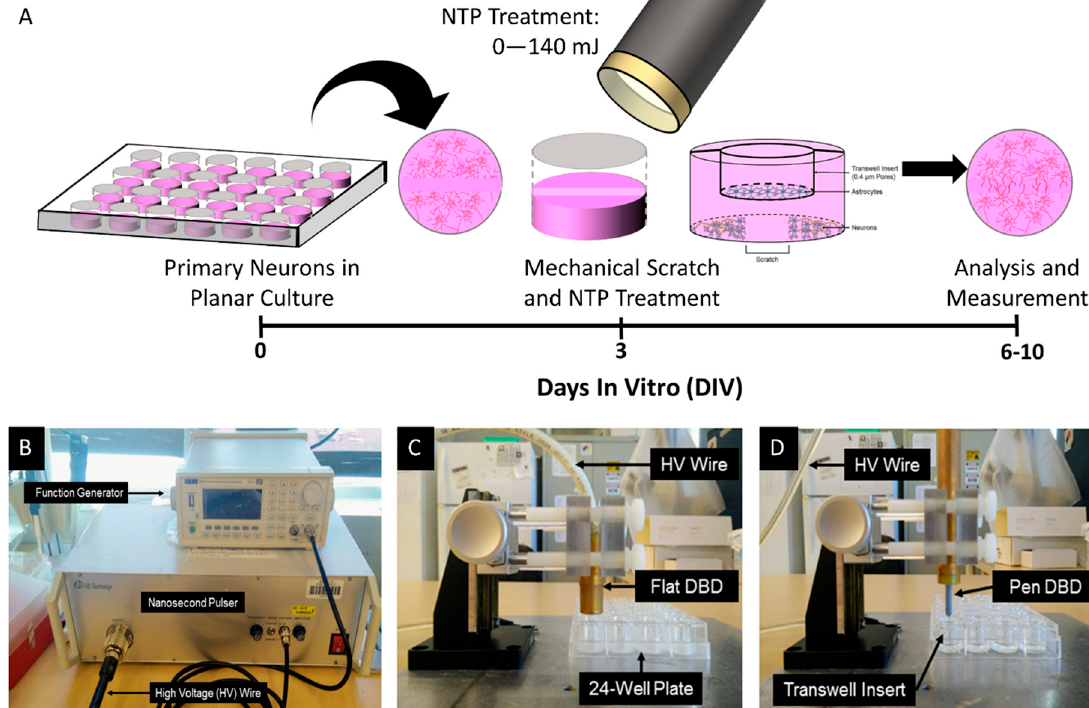
Figure 1. Non-thermal plasma (NTP) was applied to neural cultures using a nanosecond-pulsed dielectric barrier discharge (nspDBD) system for all plasma treatments. ( A ) Primary neurons were plated in 24-well plates, subjected to mechanical disruption via a scratch assay, and treated with NTP 3 days after plating. For the co-culture group, astrocytes cultured in Transwell inserts were added to neuronal cultures at this point, and cell/neurite infiltration into the gap was assessed at 6–10 DIV. ( B ) A nanosecond-pulser was used to generate and deliver high voltage (HV) pulses to the dielectric barrier discharge (DBD) electrode. A function generator was used to control NTP treatment energy by setting the frequency of pulses and the duration of treatment. A z-positioner was used to fix the position of the ( C ) flat DBD electrode or the ( D ) pen DBD electrode 1 mm above the cells treated in 24-well plates or Transwell inserts,